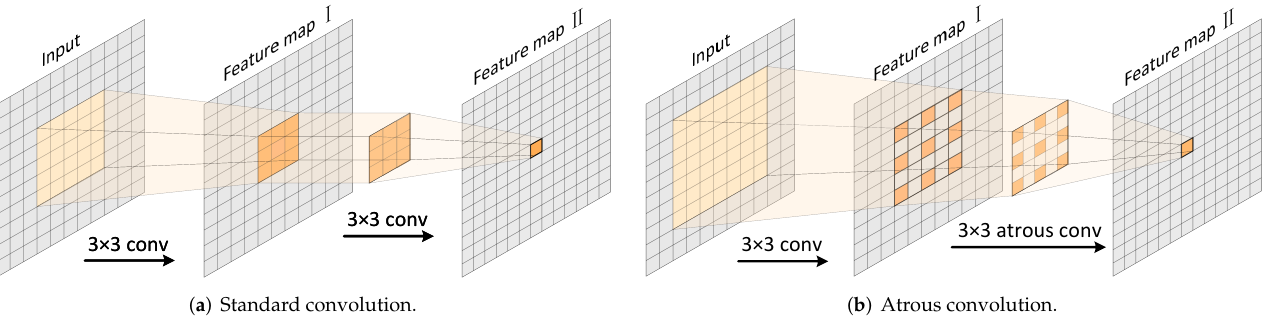
Figure 4. Standard convolution and atrous convolution. The receptive field of a feature map II is enlarged by implementing atrous